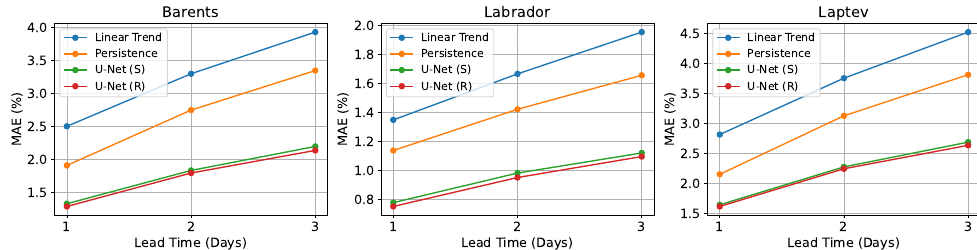
Figure 5. Dependence of JAXA SIC MAE (lower is better) on the different forecast horizons (in days) for all three regions. MAE is averaged over the whole 2021 year. The linear trend is computed cell-wise over 3 previous days; U-Net (S) and U-Net (R) are trained on all three regions merged and shuffled, with 7 days history (past) and best inputs configuration, as presented in Table 3.